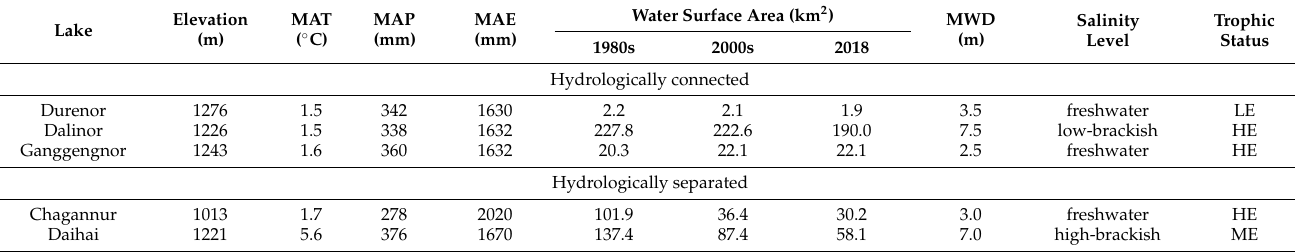
MAT, mean annual temperature; MAP, mean annual precipitation; MAE, mean annual evaporation; MWD, mean water depth in 2018; LE, light eutrophic; HE, hyper eutrophic; ME, middle